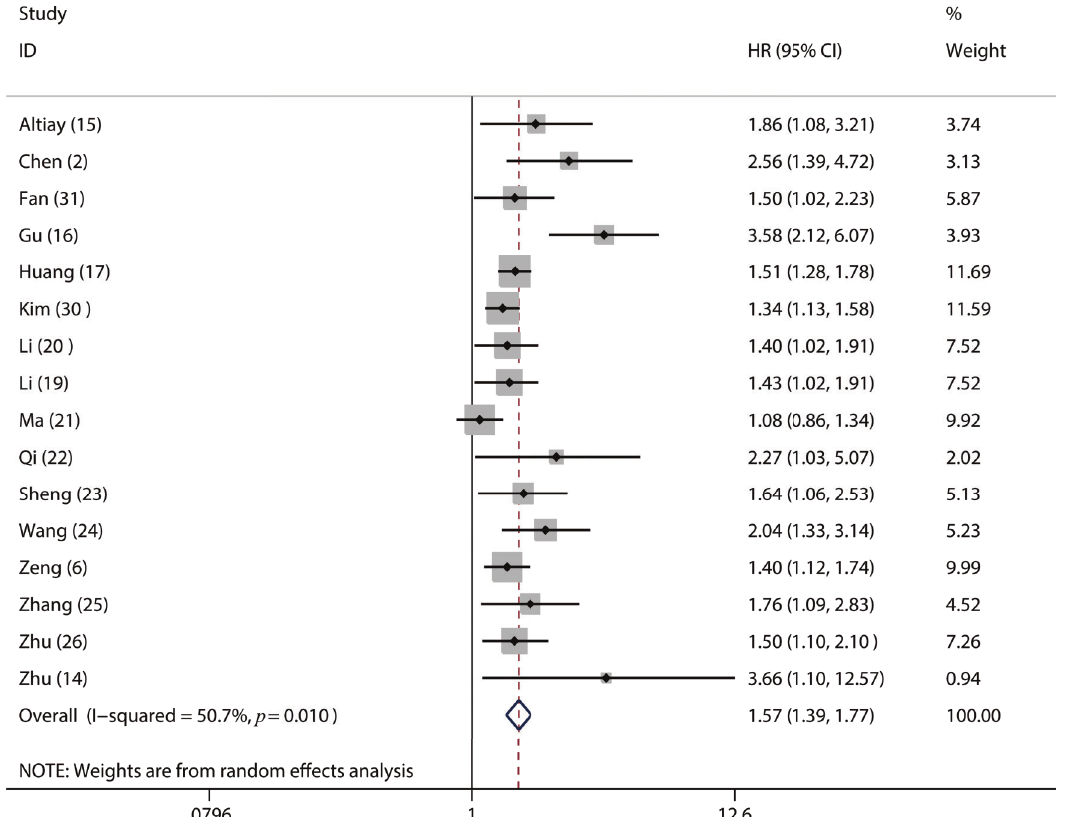
Figure 2 - Forest plot of the hazard ratio (HR) for the association between the plasma fibrinogen level and overall survival (OS) in patients with lung cancer.